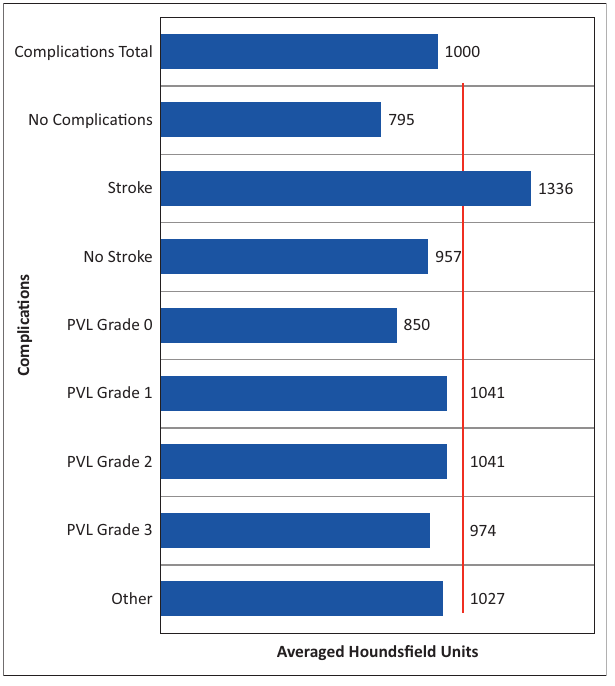
PVL, paravalvular leak. FIGURE 5: Averaged Hounsfield units versus complications.